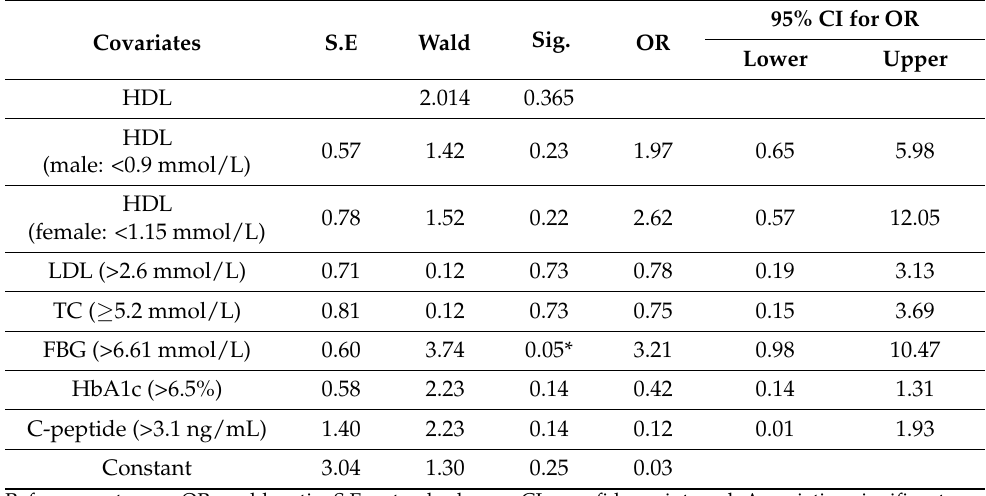
Table 10. Prediction of risk factors associated with plasma vitamin E level.